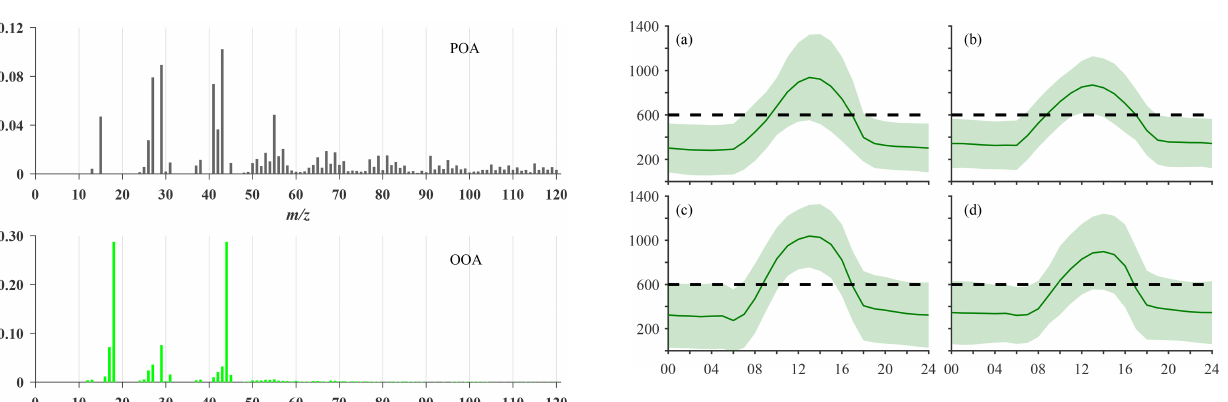
Figure 3. Diurnal variations of the reanalysis PBLH in spring (a) , summer (b) , fall (c) , and winter (d) at the grid box where the Shang- hai Tower (SHT) site is in. The solid line represents the mean value, and the shaded area stands for the standard deviation. The dashed lines represent the altitude ( ∼ 600m) of the SHT